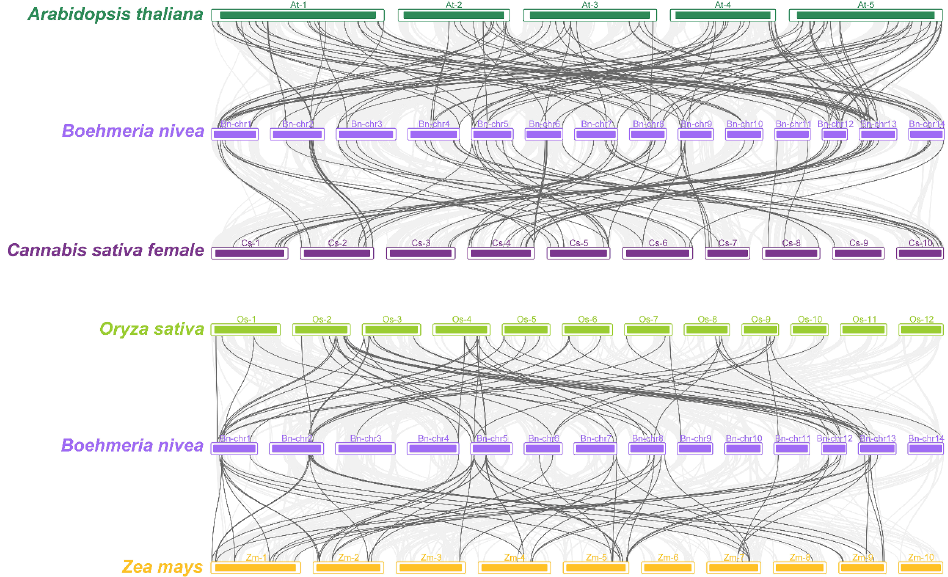
Figure 5. Gene duplication and synteny relationship of BnAP2/ERF genes between ramie and A. thaliana , C. sativa , O. sativa , and Z. mays . The deep gray lines stand for the syntenic AP2/ERF gene pairs, and the light gray stands for collinear blocks.